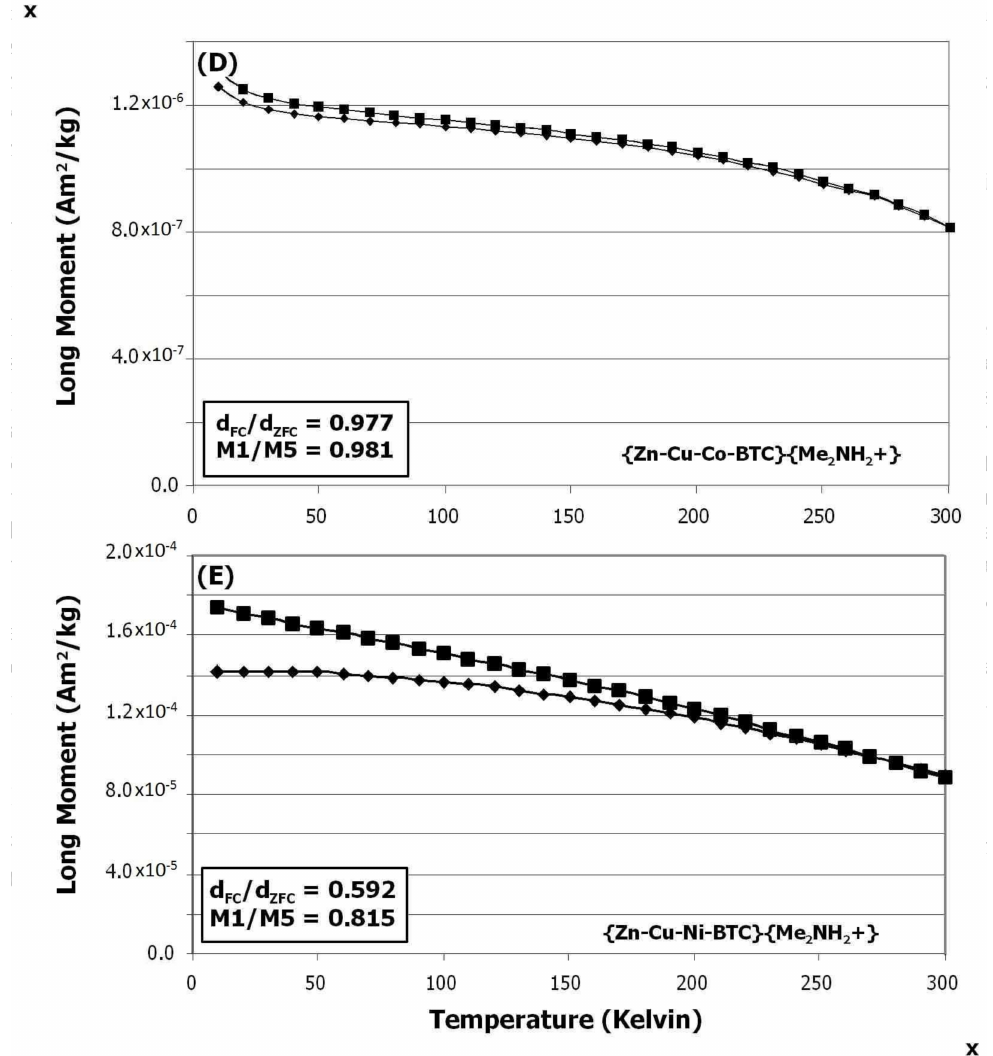
Figure 9. Field cooled (FC) and zero-field cooled (ZFC) experimental data within a constant applied field of 0.001 T remanence on warming (ROW) experiments for {Zn-BTC}{Me 2 NH 2+ } ( A ); {Zn-Mg-BTC}{Me 2 NH 2+ } ( B ); {Zn-Ni-BTC}{Me 2 NH 2+ } ( C ); {Zn-Cu-Co-BTC}{Me 2 NH 2+ } ( D ); {Zn-Cu-Ni-BTC}{Me 2 NH 2+ } ( E ). The ratio of the δ FC/ δ ZFC and the ratio of M1/M5 provided an estimate of the magnetic domain